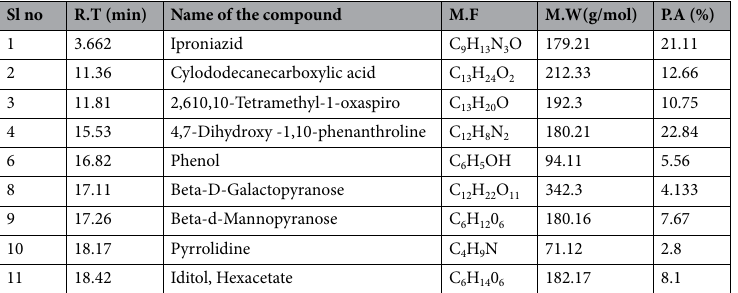
Table 9. Relative percentage of sugars and fatty acids in palm jaggery .